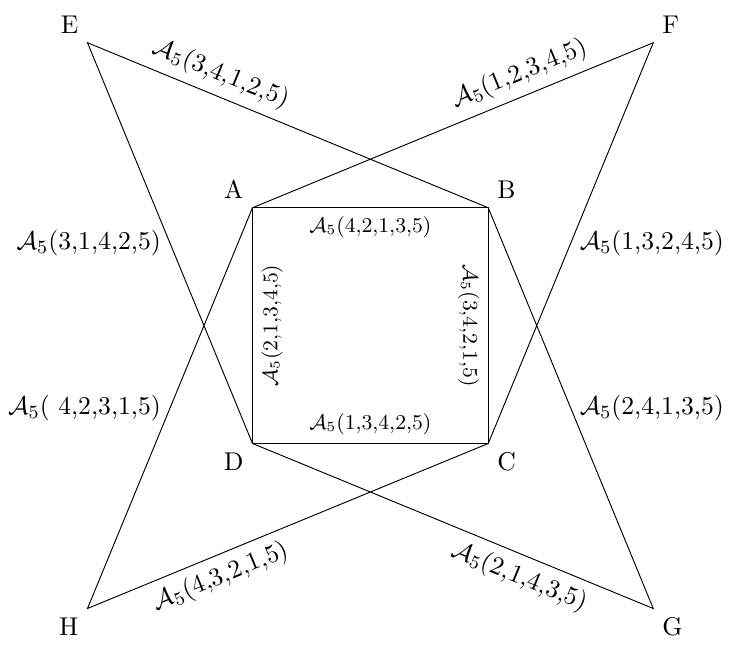
Figure 8. Combined Plahte diagram of 5-point tachyon